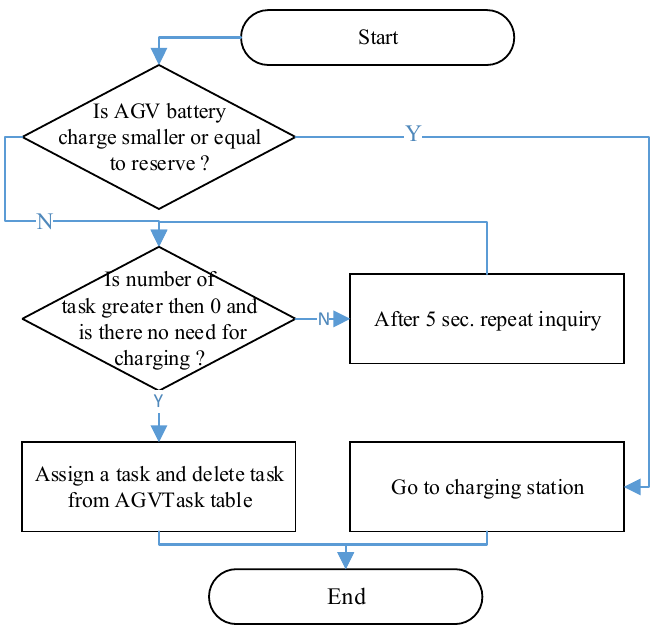
Figure 10. Task assignment logic and returning to a parking charging point schematically.